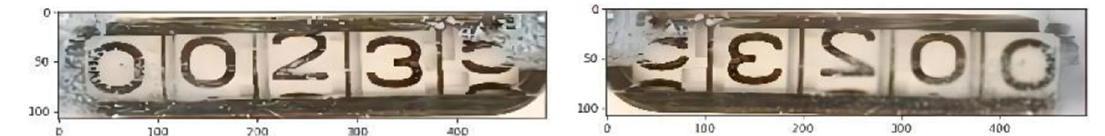
Figure 9. Water meter image after geometric transformation.